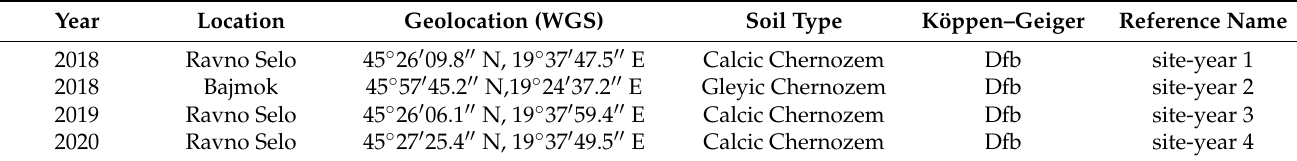
Table 1. Year, location, climate, and reference names of the